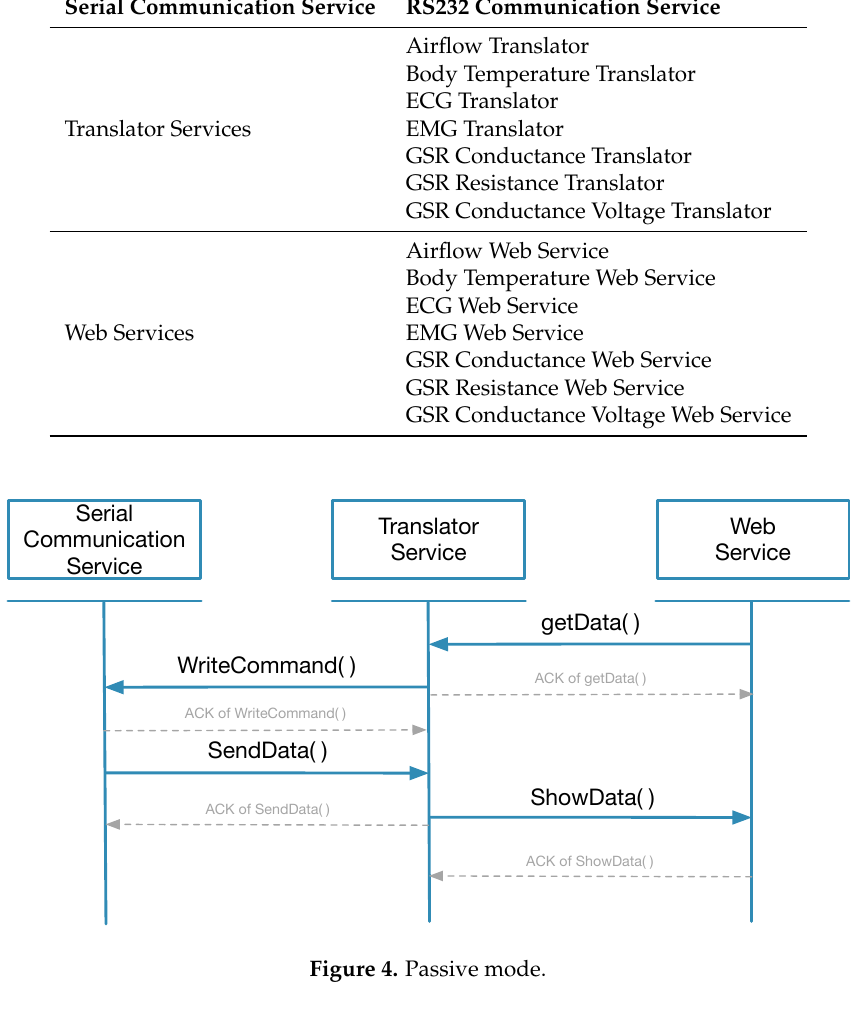
Table 4. Classification and list of services in the Serial Communication and the RS232 Communication components.